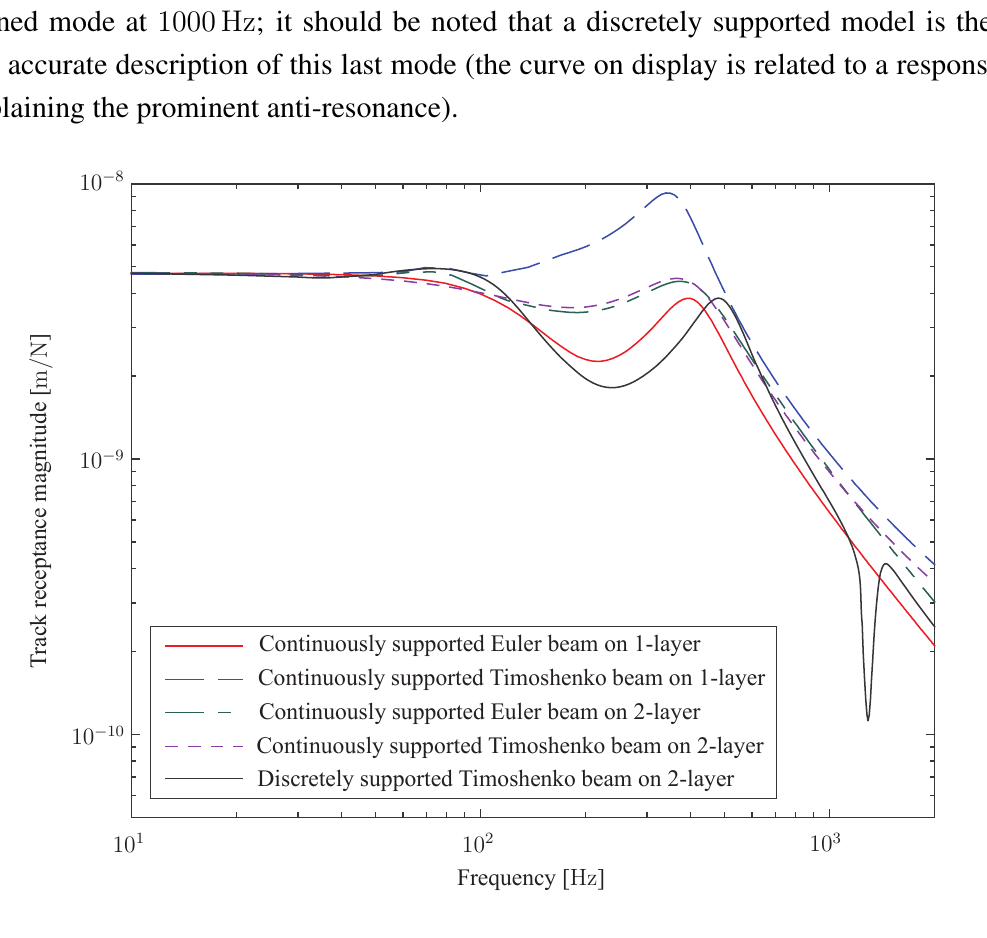
Figure 9. Track receptances calculated using numerical